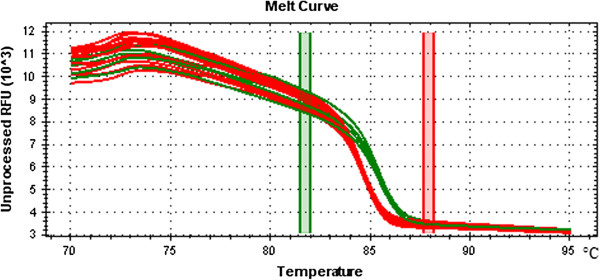
High resolution melting analysis (HRM) of PCR amplicons for gene GRMZM2G467339 in 16 maize inbreds. Red and green curves indicate SNP loci A and G, respectively.